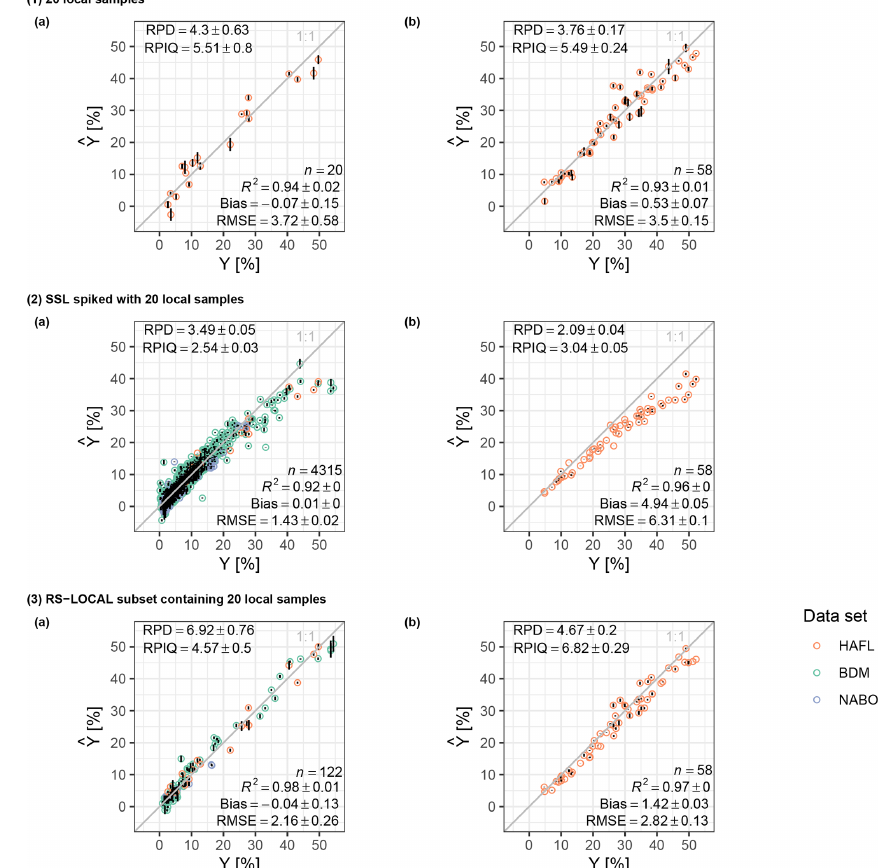
Figure 6. Predicted ( ˆ Y ) vs. observed ( Y ) total carbon content (percent) by calibrating a PLSR with 20 local HAFL samples (a) and validating it with the remaining local HAFL samples ( n = 96) (b) . A PLSR was calibrated using only 20 local HAFL samples (1), adding the entire SSL to the 20 local HAFL samples (2) and using a RS-LOCAL subset of the SSL also containing the 20 local samples (3). The error bars signify the SD, and where none are present, the components remained identical across five repetitions and, thus, SD =